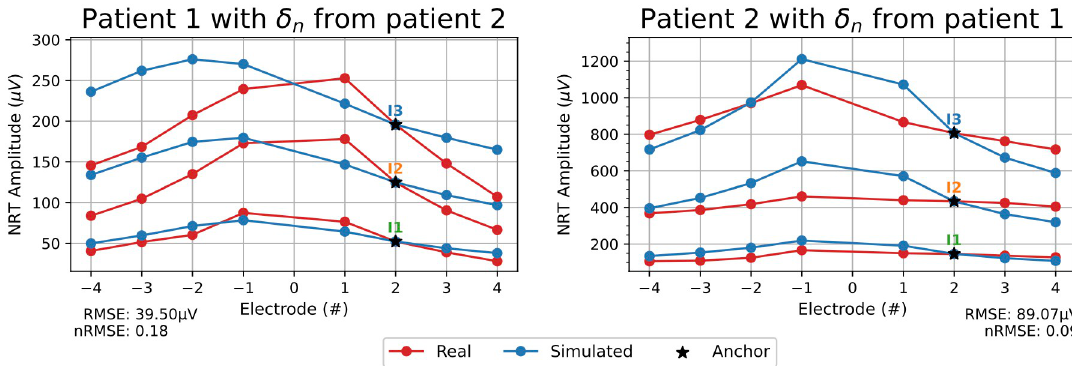
Fig 14. NRT prediction test. NRT amplitudes of the patient 1 and electrode 6 with δ n taken from the patient 2 (left), and NRT amplitudes of the patient 2 and electrode 18 with δ from patient 1 (right). RMSE and normalized RMSE (nRMSE) values are shown. n Stimulation currents: I 1 = 0.41 mA, I 2 = 0.65 mA, I 3 = 1.02 mA.